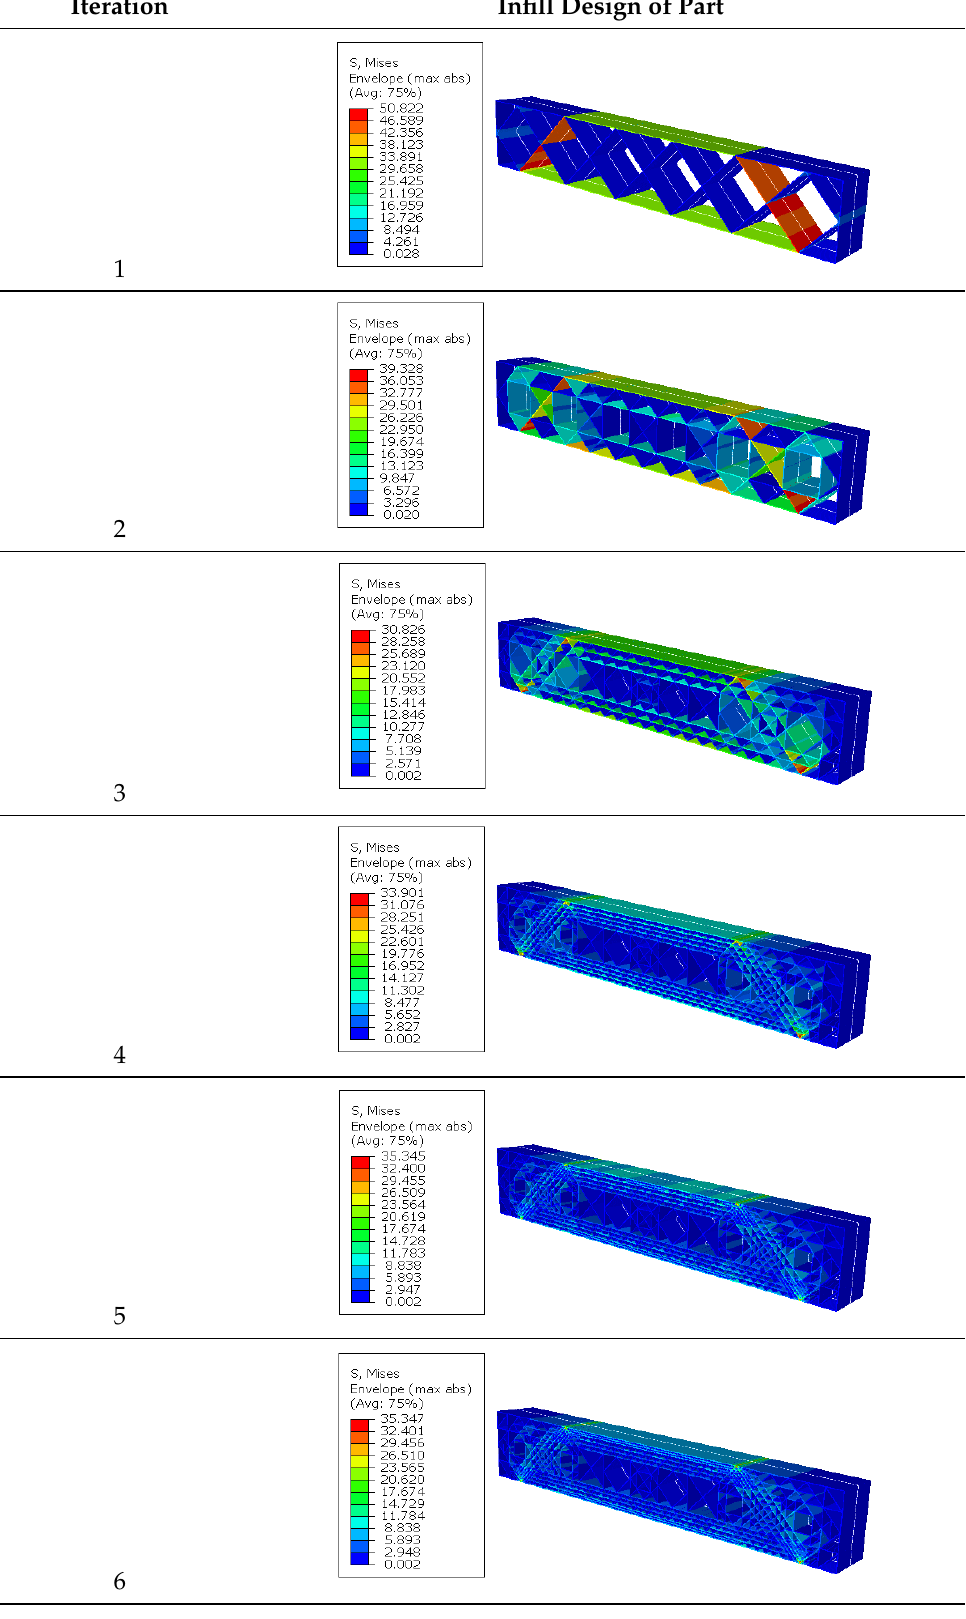
Table 2. Figures of von Mises stress distribution for each iteration in Table 1 obtained in